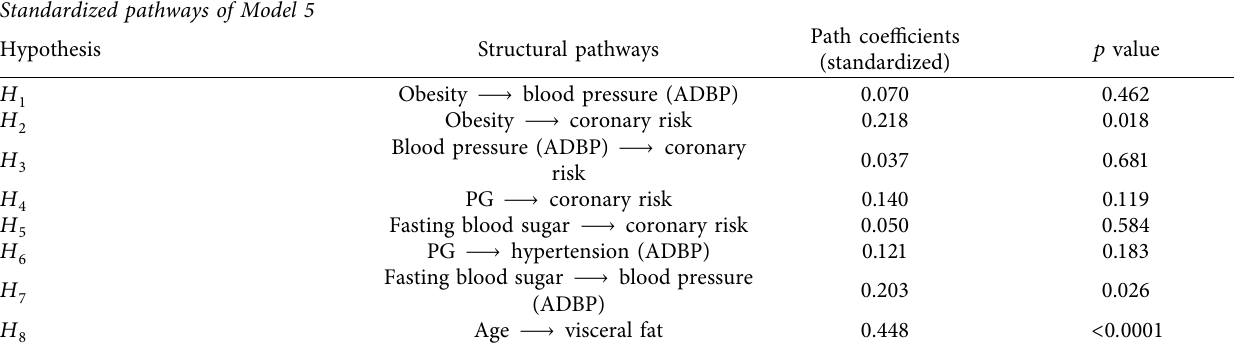
Table 8: Standardized pathways and type of effects of Model